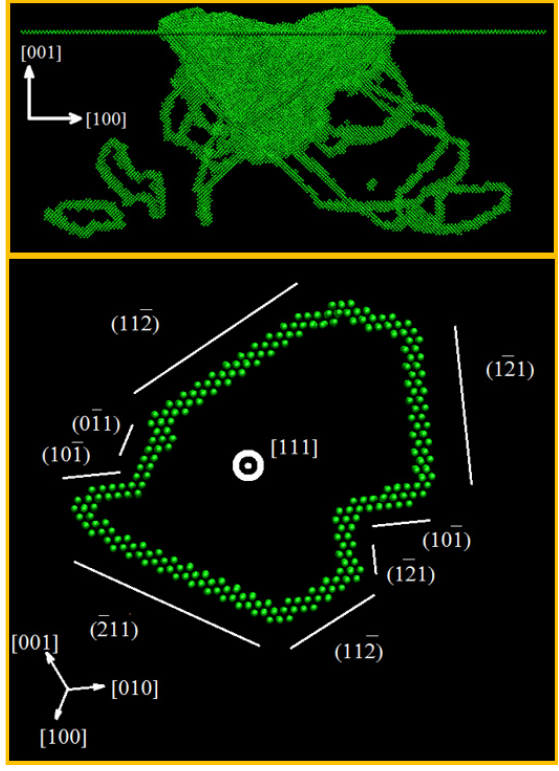
Figure 1. Prismatic loop formation in bcc Ta, see text. Original contribution of the